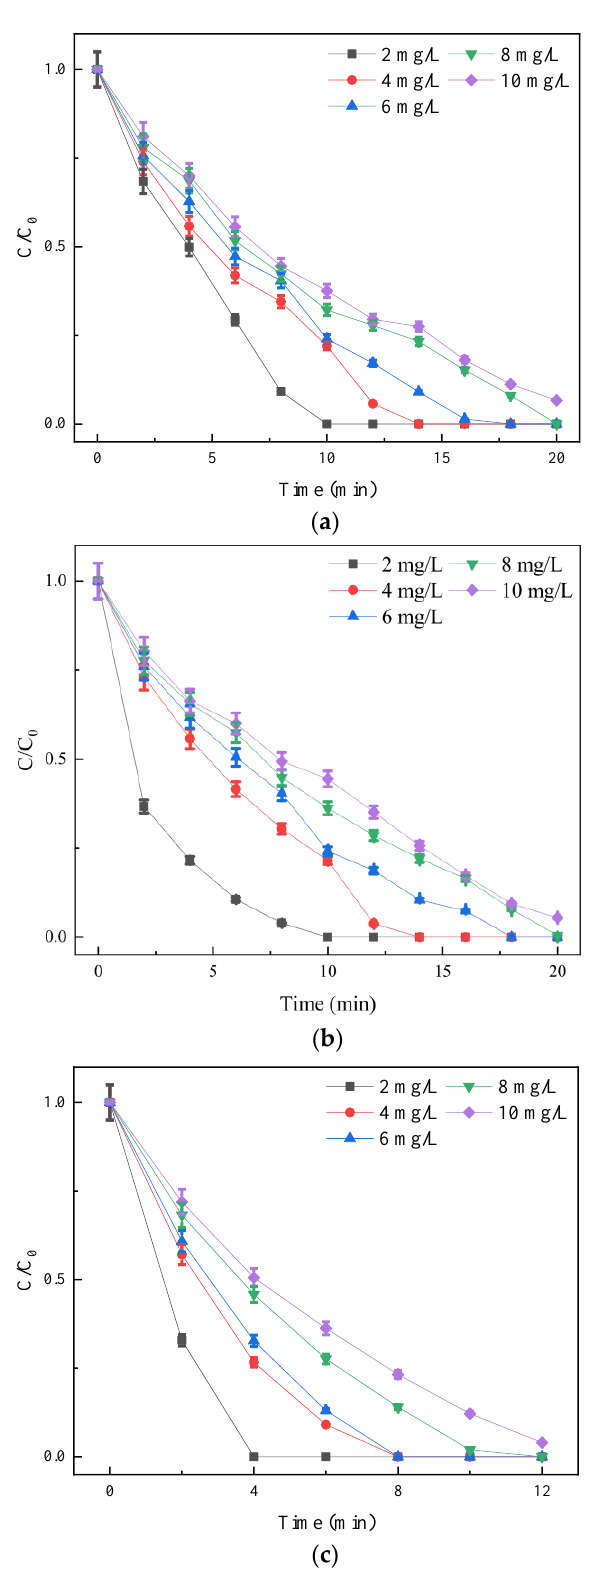
Figure 4. Effect of initial mass concentration of SDZ on degradation effect of O 3 , O 3 /UV, and O 3 /PMS (reaction conditions: SDZ = 2, 4, 6, 8, 10 mg/L, O 3 = 3 mg/L, T = 25 ± 0.5 ◦ C, pH = 6.8 ± 0.1, O 3 /PMS (PMS = 22.8 mg/L), UV = 0.9 mw/cm 2 ). ( a ) O 3 , ( b ) O 3 /UV, ( c ) O 3